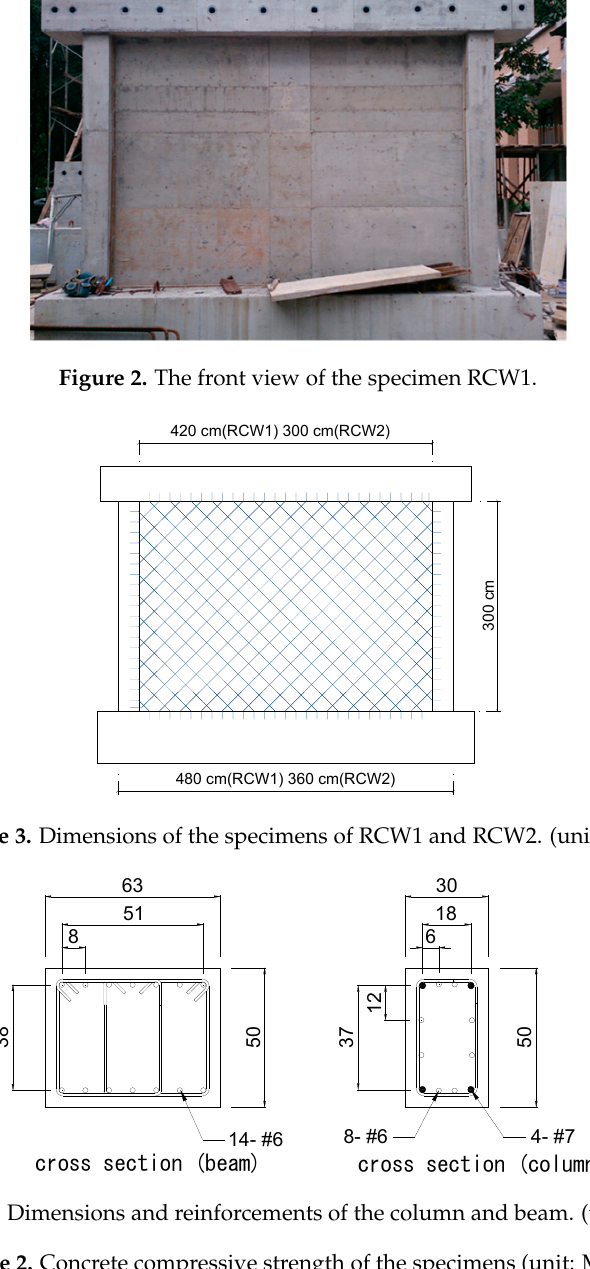
Figure 2. The front view of the specimen RCW1. Table 2. Concrete compressive strength of the specimens (unit: MPa).